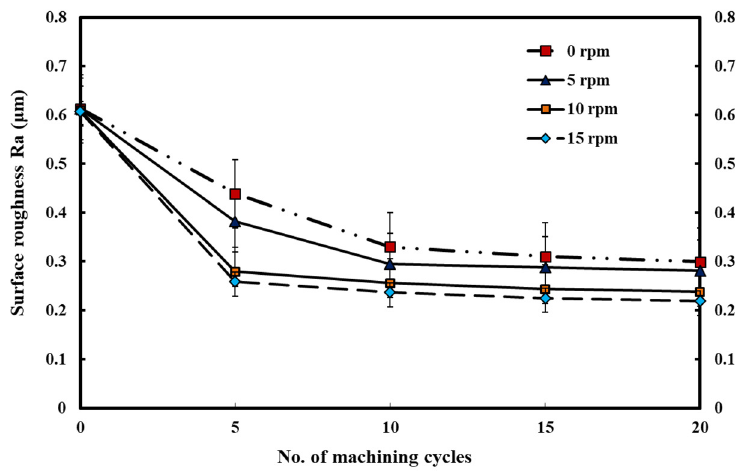
Figure 7. Effects of rotational speed on surface roughness measurements.